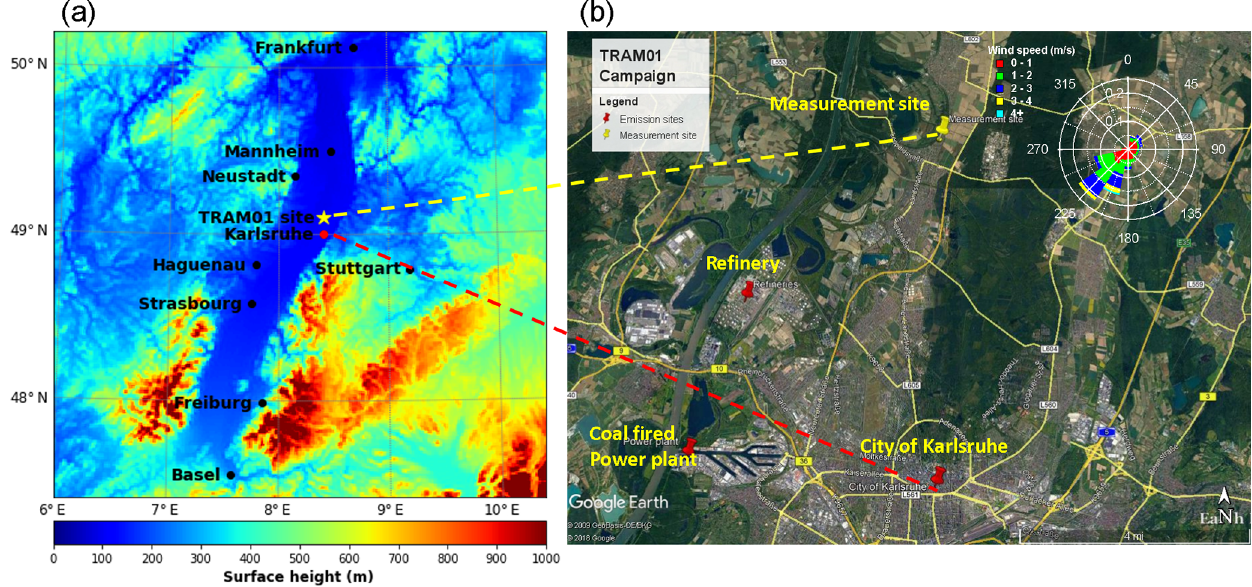
Figure 1. Measurement location and topography (a) ; nearby peak emission sites and wind rose for the complete measurement campaign in summer 2016 (b)